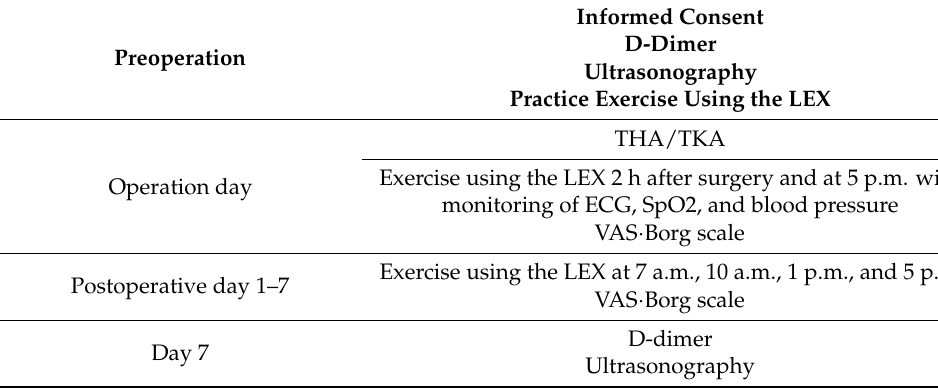
Table 3. Procedure